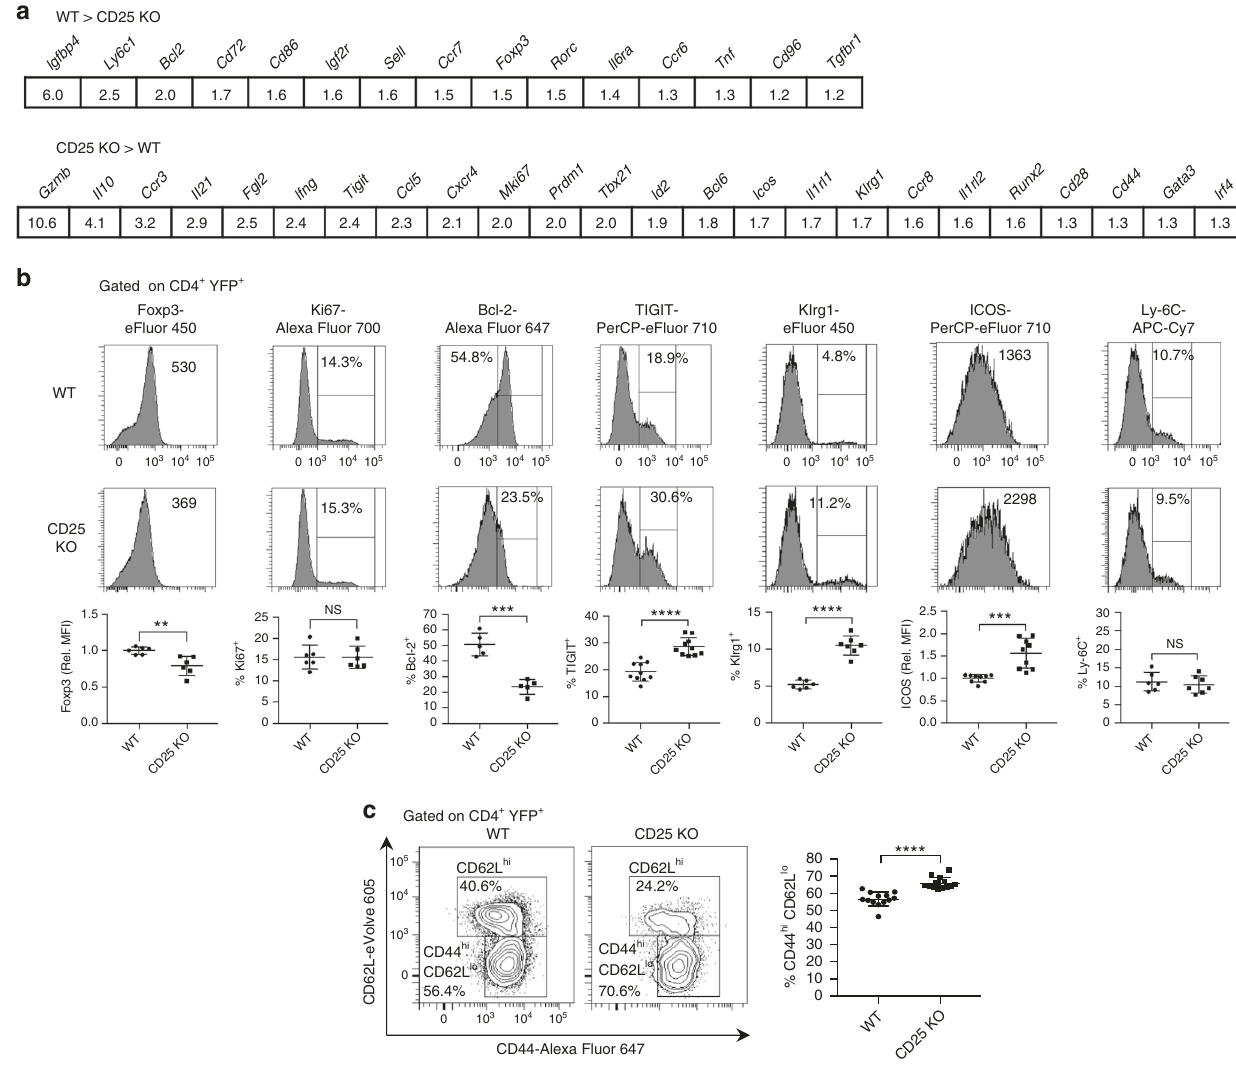
Fig. 8 CD25 de fi ciency in peripheral Tregs initially favors survival of eTregs. a Selected immunological genes downregulated (top) or upregulated (bottom) in splenic CD25 KO Tregs from tamoxifen-induced CD25 fl ox/Foxp3eGFP-Cre-ERT2/R26Y mice evaluated by RNA-seq. Statistical signi fi cance is FDR < 0.01 for all comparisons. b Expression of indicated markers in splenic YFP + Tregs from CD25 fl ox/Foxp3eGFP-Cre-ERT2/R26Y mice (shown as CD25 KO) and reporter controls was measured by ex vivo fl ow cytometry 10 – 14 days after tamoxifen induction ( n = 5 – 10 mice per group). Representative histograms (upper panels) and scatter plots (lower panels) are shown. c Representative contour plots (left) and scatter plot (right) showing the proportion of splenic YFP + Tregs with a CD44 hi CD62L lo eTreg phenotype ( n = 13 mice per group). Rel. MFI = relative MFI normalized to CD25 WT controls. Each symbol represents an individual mouse ( b , c ; mean ± SD). NS, not signi fi cant ( p > 0.05), ** p < 0.01, *** p < 0.001, **** p < 0.0001 (two-tailed Student ’ s t test). Data are representative of, or pooled from ( b , c ) three independent